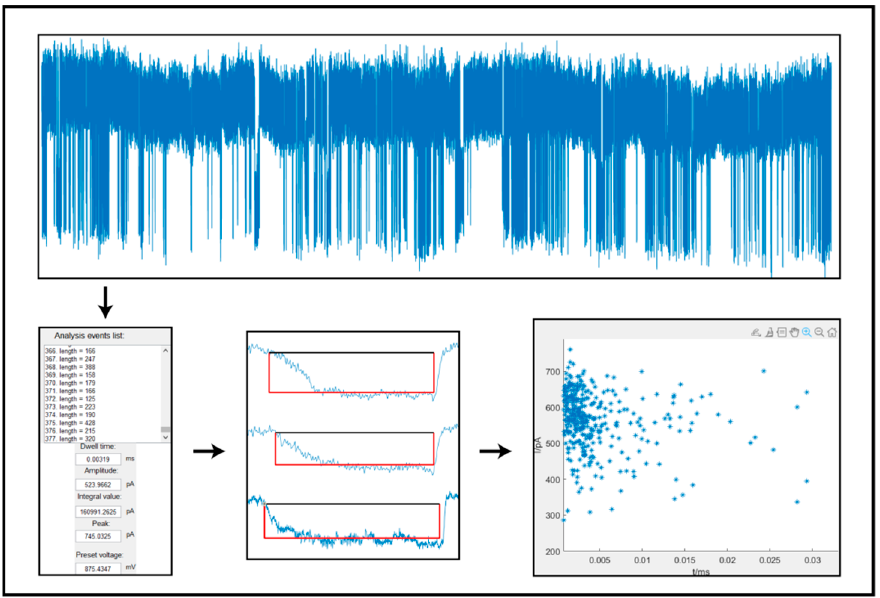
Figure 2 . The nanopore signal processing interface on MATLAB program. Figure 2. The nanopore signal processing interface on MATLAB